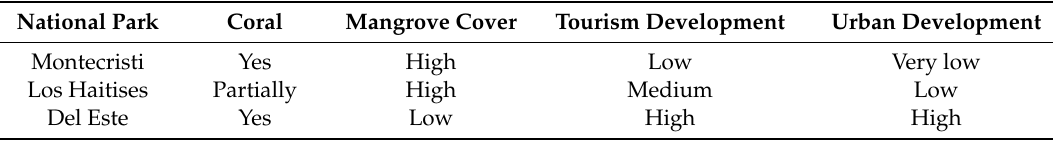
Figure 1. Location of the national parks (NP) studied and UTM (Universal Transverse Mercator) coordinates found in the legislation [32], as well as high-impact tourism areas. Table 1. Brief description of the national parks